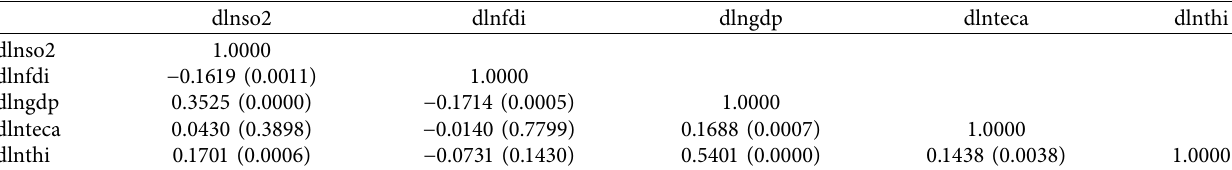
Table 10: Correlation analysis of each variable.